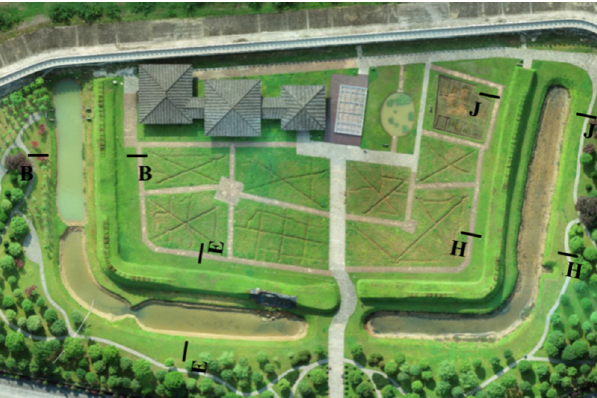
Figure 6. Location of dangerous sections.